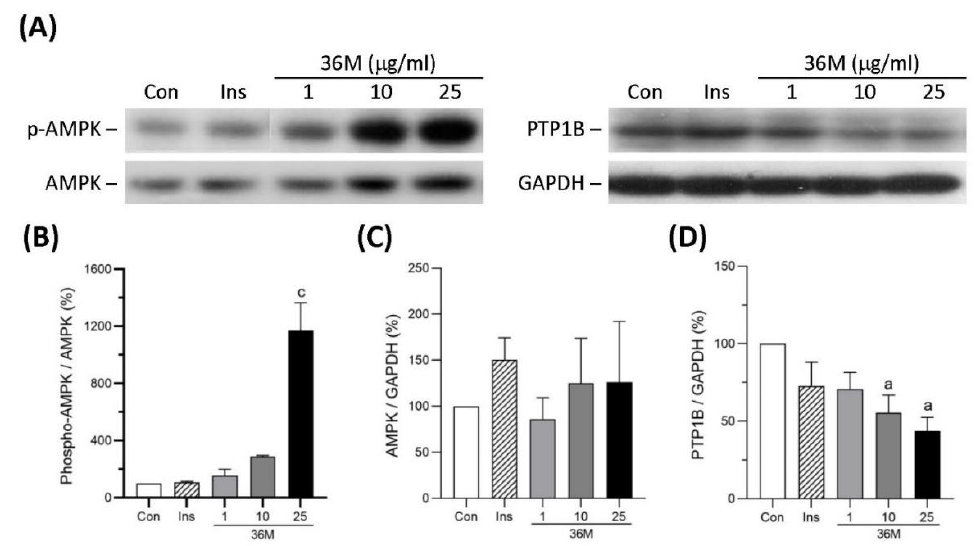
Figure 2. Protein expression of AMPK and PTP1B in C2C12 myotubes. ( A ) The representative immunoblot images for phosphorylated AMPK (p-AMPK), AMPK, PTP1B, and GAPDH. These protein expressions were detected by Western blotting. ( B – D ) The quantified results of the blots. The cells were stimulated with 1, 10, or 25 μ g/mL of 36M or 0.32 μ M of insulin (Ins) for 8 h. Con: control cells without treatment. Data are mean ± SE (n = 3). Compared to control; a: p < 0.05; c: p < 0.001.